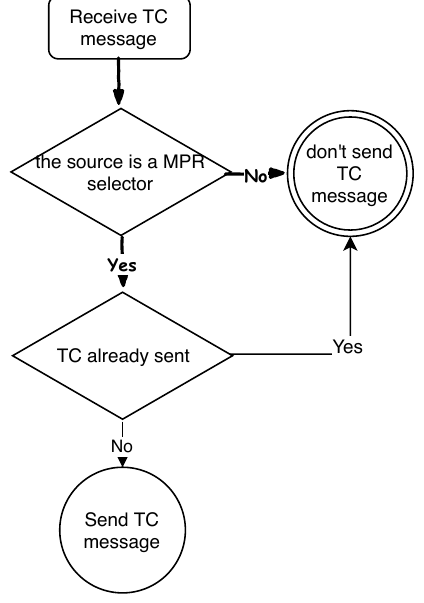
Figure 5. Default forwarding rules of